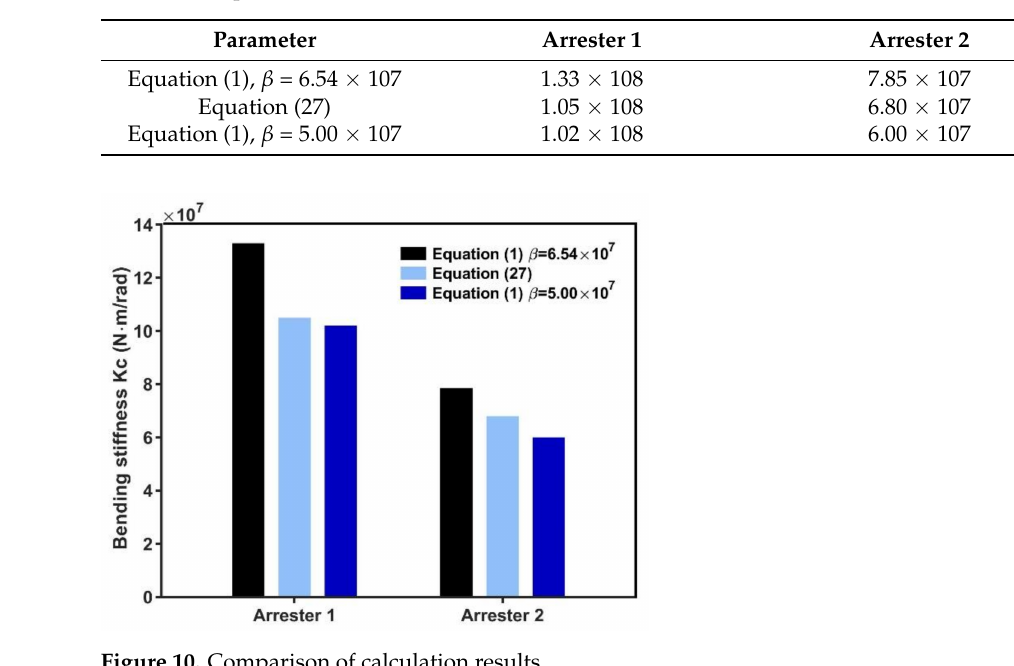
Table 6. Comparison of calculation results (Unit: N · m · rad − 1 ).